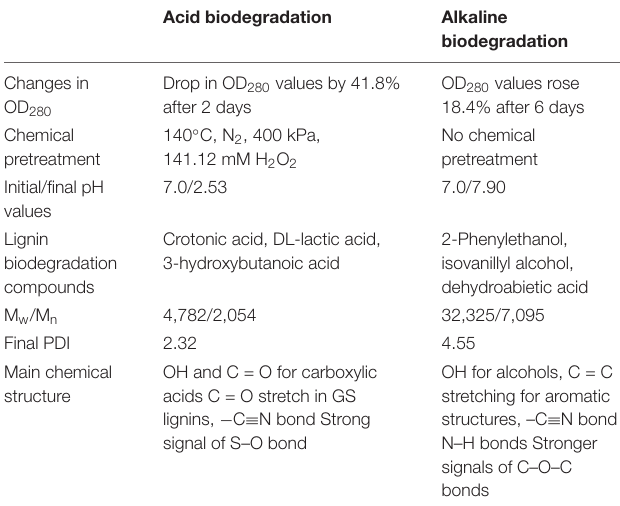
TABLE 5 | Summary of a general comparison between acid versus alkaline biodegradation of lignin by E. coli BL21(Lacc). Acid